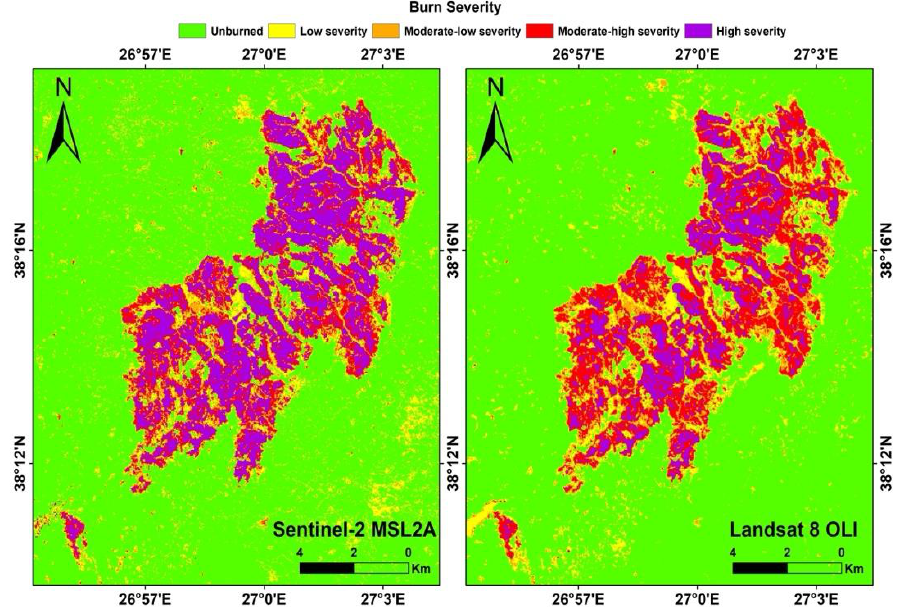
Figure 6. Burn severity maps derived from Sentinel-2 and Landsat-8.